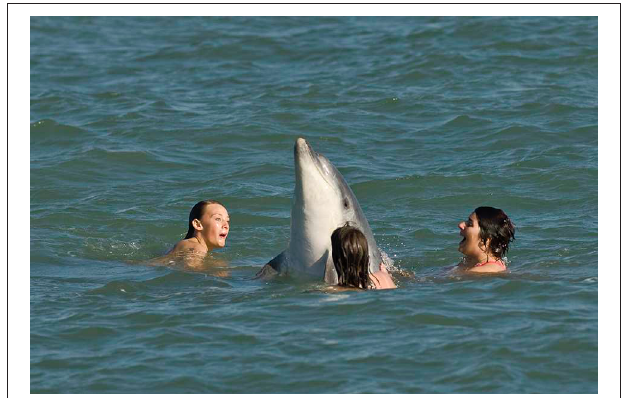
FIGURE 2 | “Dave” the solitary-sociable dolphin, interacting with a group of people in Kent, UK (Photo: Terry Whittaker).